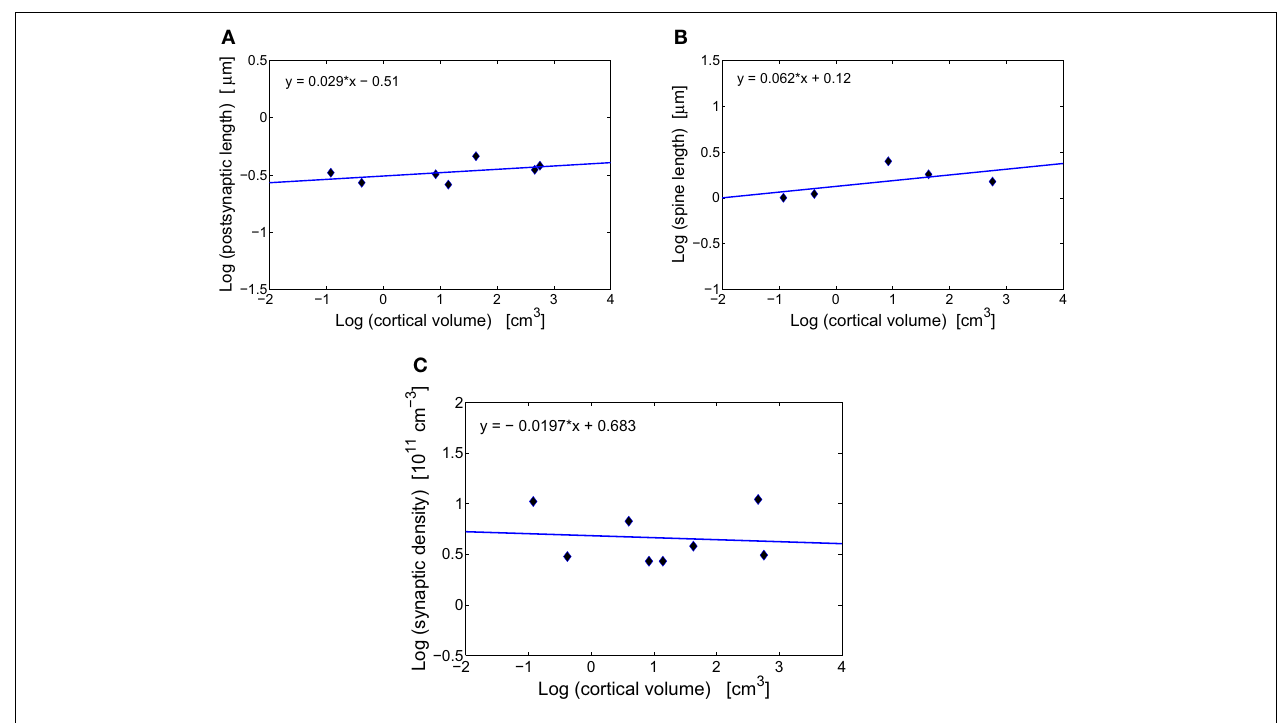
FIGURE 1 | Scaling of synaptic characteristics with cortical volume. (A) Conservation of postsynaptic density length of excitatory synapses across mammals. The log–log fit to the data points yields a scaling exponent close to zero ( y = 0 . 029 x − 0 . 51), with non-significant moderate correlations ( r = 0 . 480, p = 0 . 275). (B) Conservation of spine length of excitatory